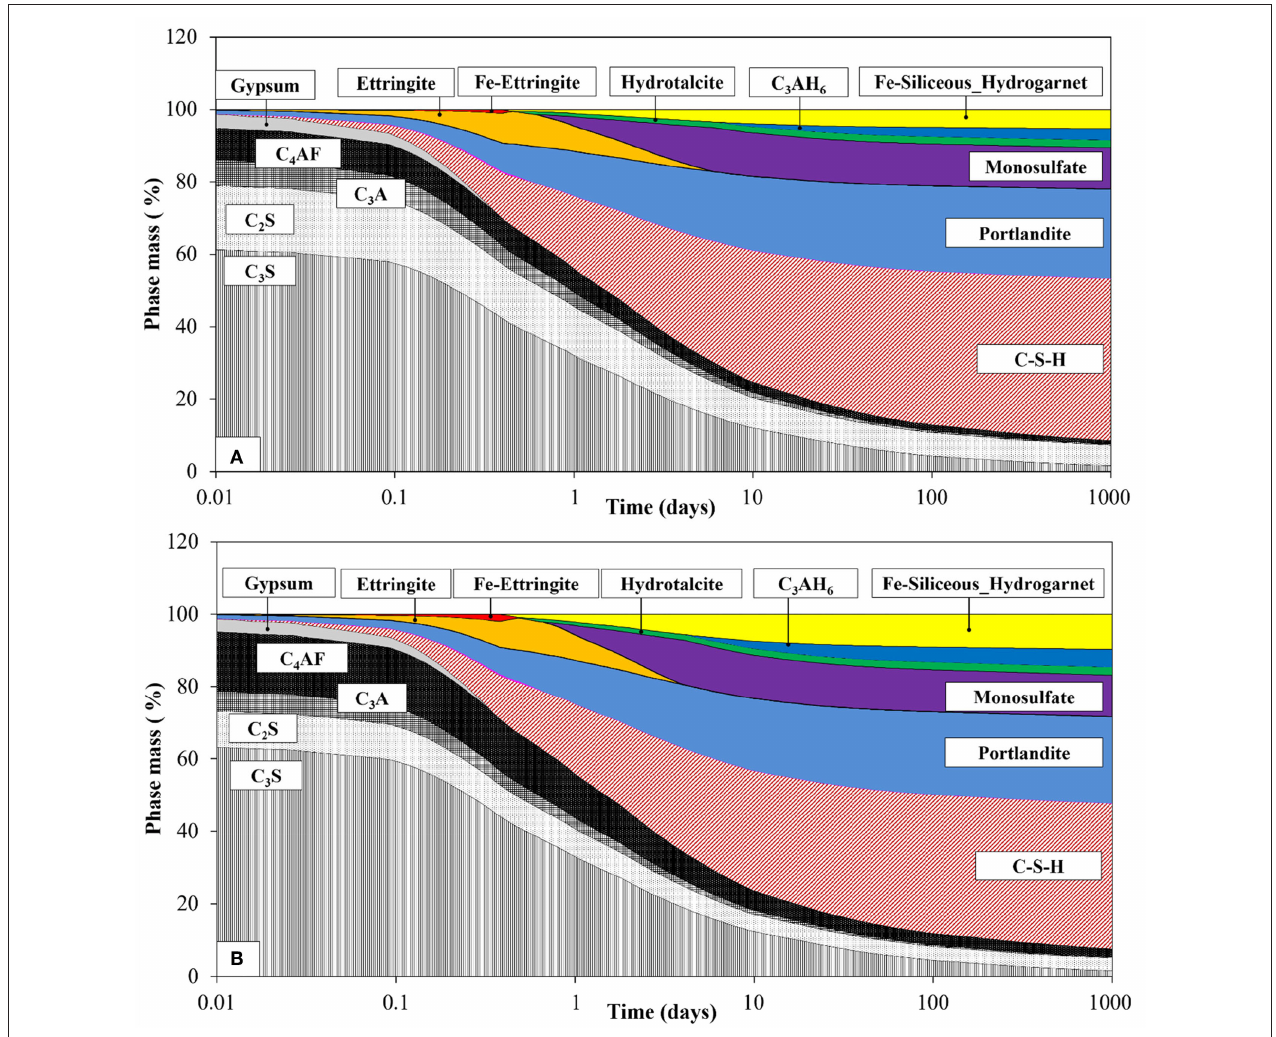
FIGURE 8 | Calculated mass of hydrates as a function of hydration time for (A) OPC and (B) FC.